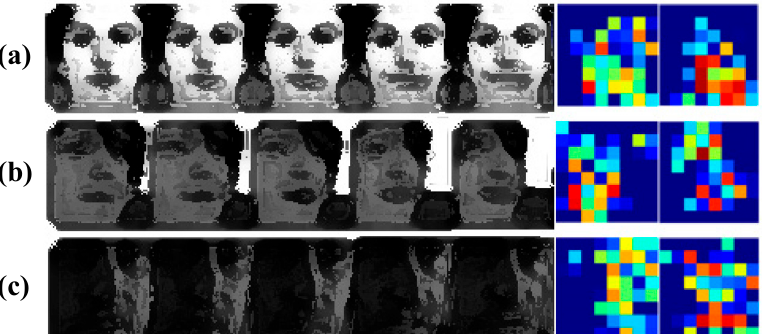
Figure 5. Visualization of hybrid attention module output features (weight increases from blue to red: dark blue–light blue correspond to 0.1–0.4, light blue–yellow correspond to 0.4–0.7, yellow–red correspond to 0.7–1). In the first five columns, the subfigures ( a – c ) show image sequences under (i) the ideal condition, (ii) the facial deflection condition, and (iii) the uneven illumination condition. We